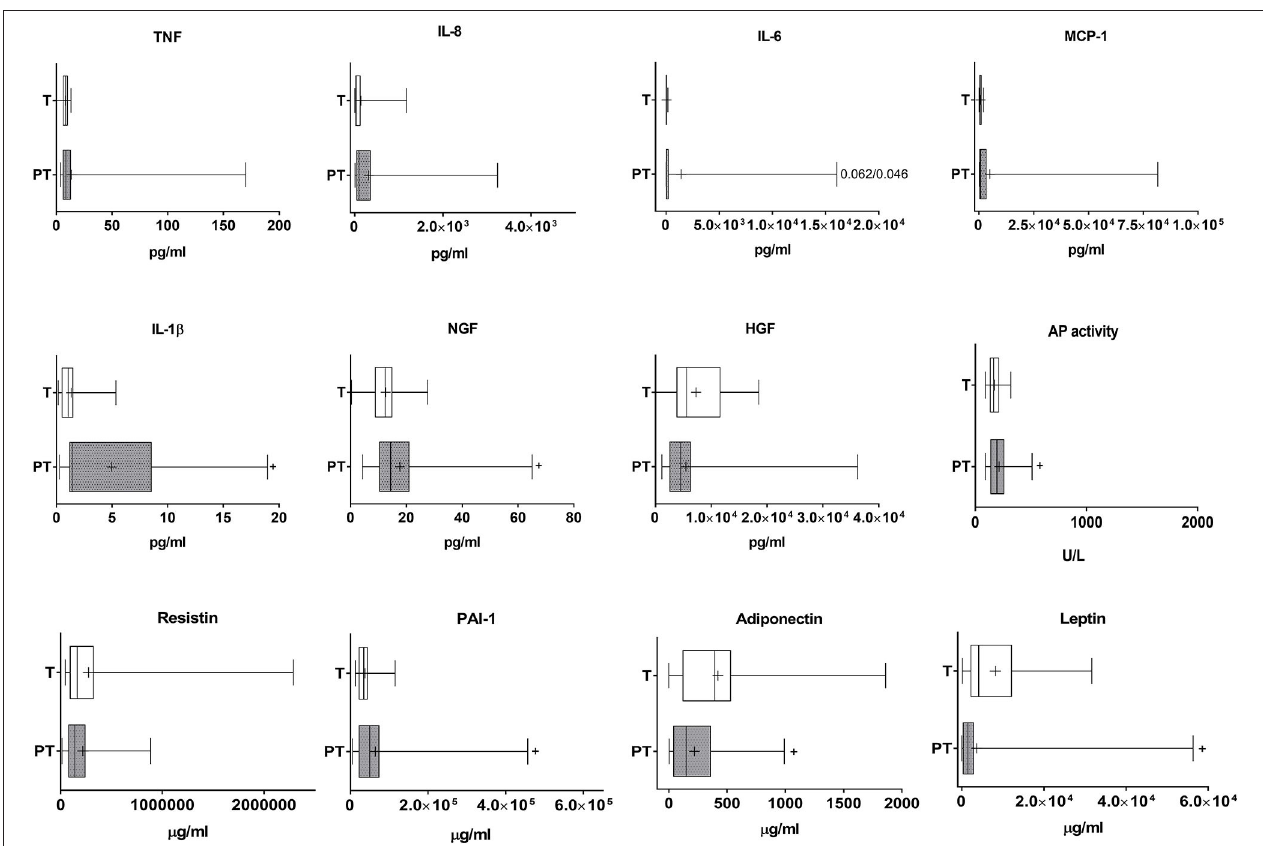
FIGURE 3 | Analysis of cytokines, growth factors, inflammatory factors and haematological markers in the plasma of T and PT newborns. TNF, IL-8, IL-6, MCP-1, IL-1 β , NGF, HGF, AP activity, resistin, PAI-1, adiponectin and nectin are shown. + p < 0.05 vs. T.